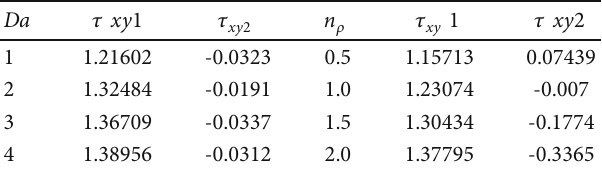
Table 1: Variation of volumetric fl ow rate with conductivity ratio ( n σ ), slip parameter ( α ), Hartmann number ( Ha ) and viscosity ratio ( n μ ).